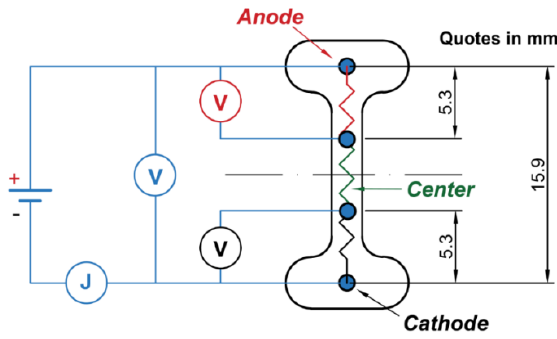
Figure 1. Schematic of the 4-point conductivity test on dog bone dense 8YSZ